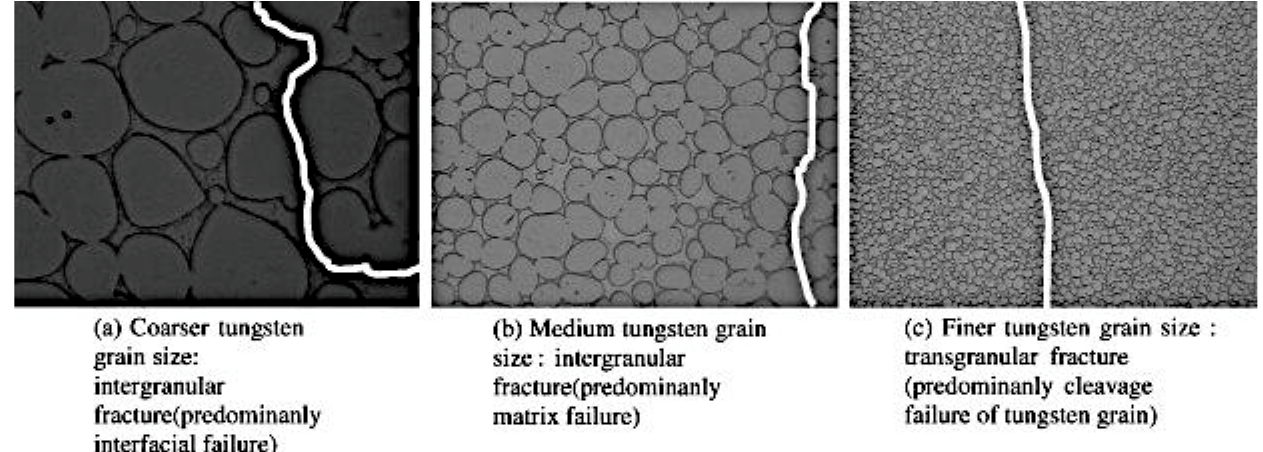
Figure 16. Schematic representation of fracture in W-heavy alloy [90].